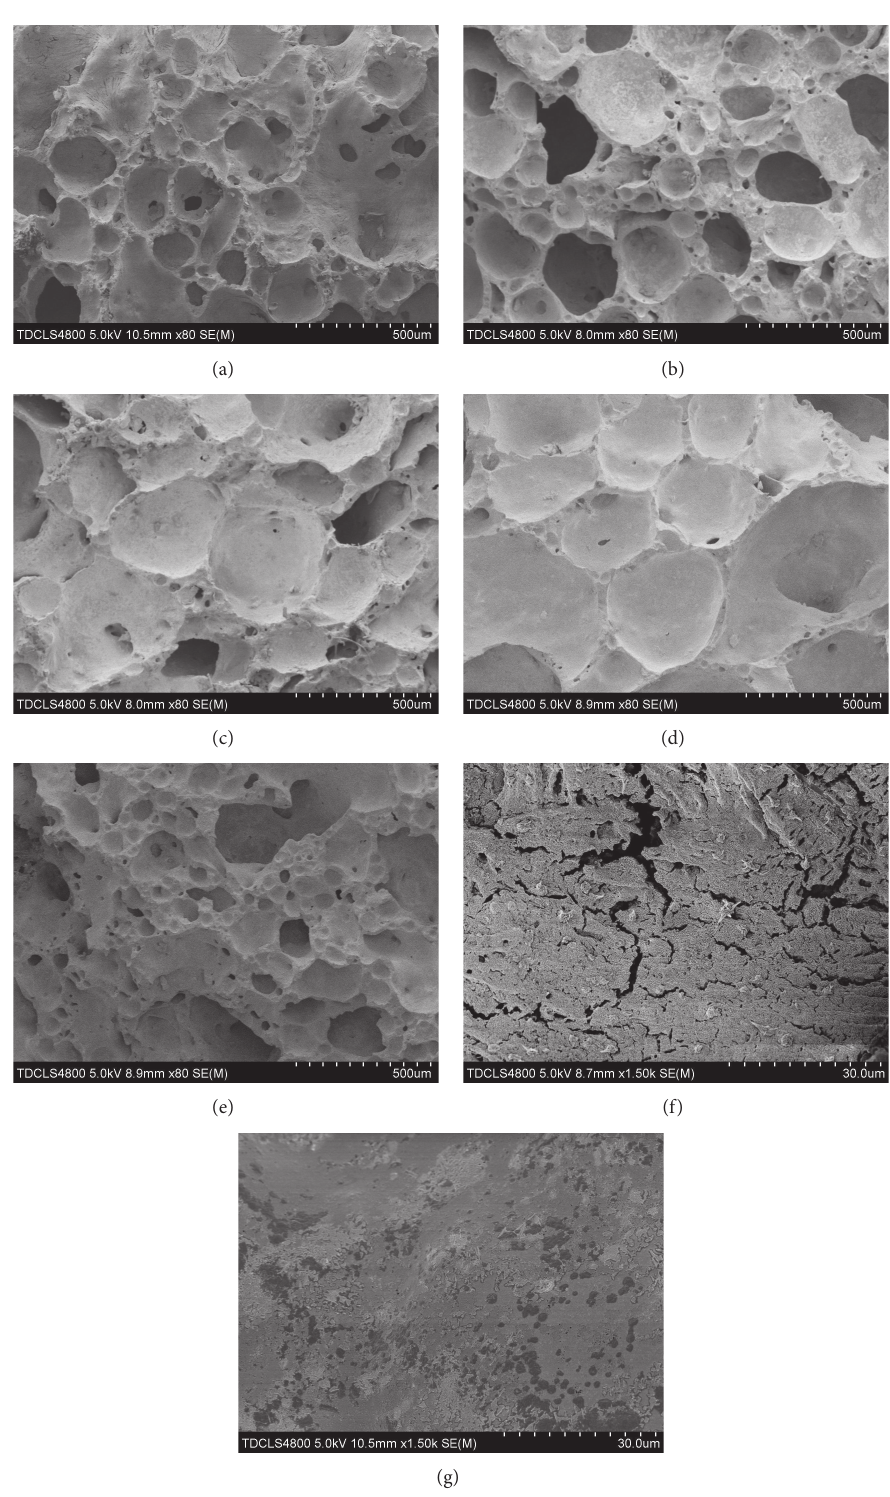
Figure 1: Fracture surface SEM micrographs of the foam glasses samples sintered at 775 ∘ C: (a) sample A, (b) sample B, (c) sample C, (d) sample D, (e) sample E, (f) f is an observation of the cell walls at higher magnification in sample A, and (g) g is an observation of the cell walls at higher magnification in sample